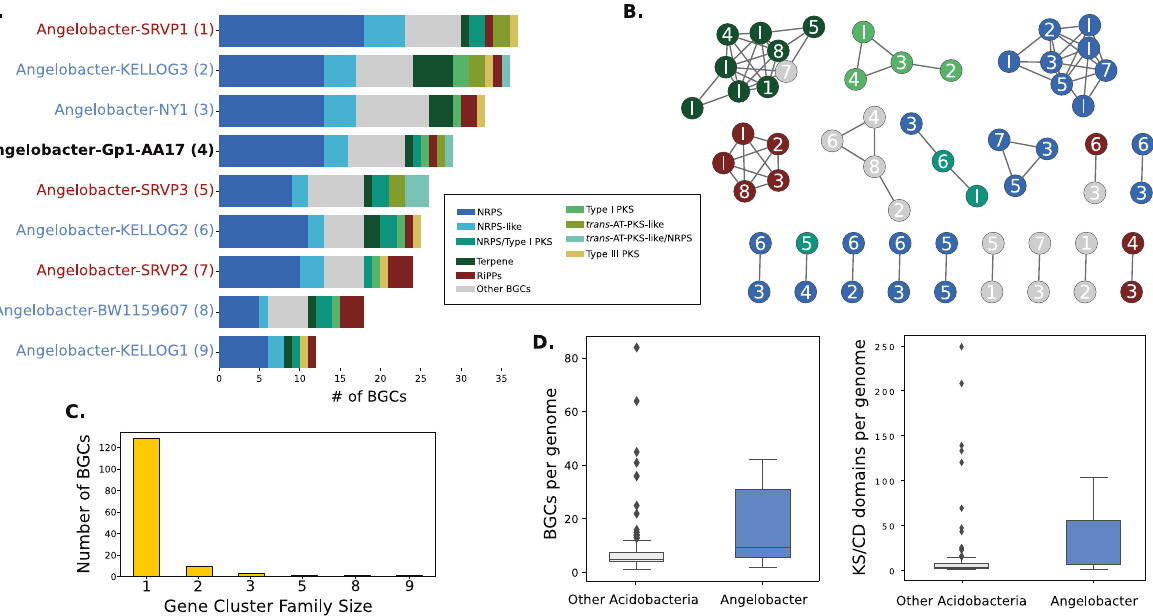
Fig. 3 Biosynthetic gene clusters from genomes in Candidatus Angelobacter. A The number and class of BGCs in each species genome from Ca . Angelobacter with at least 10 BGCs. The previously published reference genome for this genus is bolded in contrast to new genomes obtained in this study (red) and genomes identi fi ed in other studies (blue). B A BiG-SCAPE gene cluster family network of BGCs from Ca . Angelobacter. Each node is a BGC, connected to other similar BGCs by genomic similarity. Singleton BGCs are not shown. BGCs are numbered by their corresponding genome of origin, as denoted in part (a). BGCs from incomplete Ca . Angelobacter genomes not included in part (a) are marked with ‘ I ’ . Nomenclature: C, Condensation Domain; Ser, Adenylation Domain (Serine); The, Adenylation Domain (Threonine); T, Peptidyl Carrier Protein; Phe, Adenylation Domain (Phenylalanine). E, Epimerase. C The number of Ca . Angelobacter BGCs in gene cluster families of each size. D The number of BGC s per genome and ketoacyl synthase and NRP condensation domains per genome for all genomes from Ca . Angelobacter compared to the rest of the